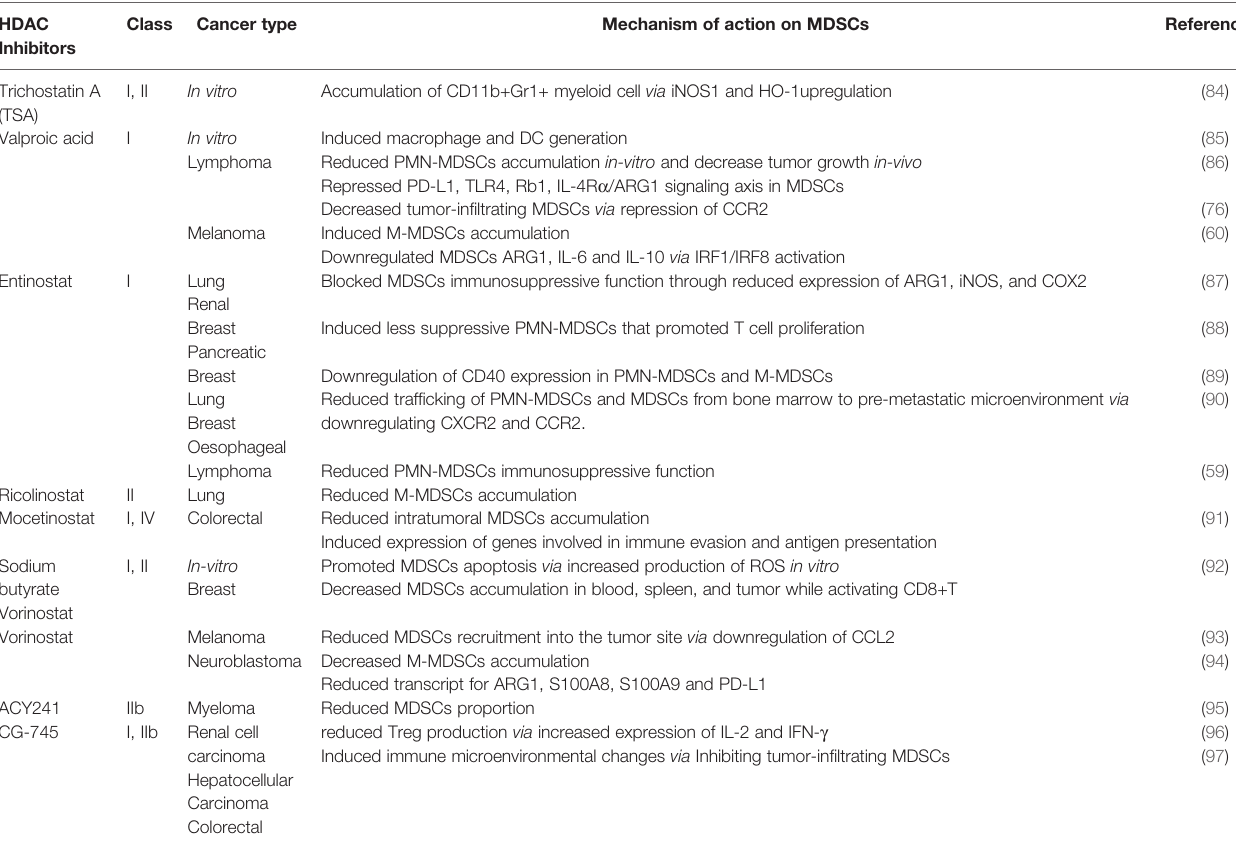
TABLE 1 | Summary of the effects of HDAC inhibitors on MDSCs in several